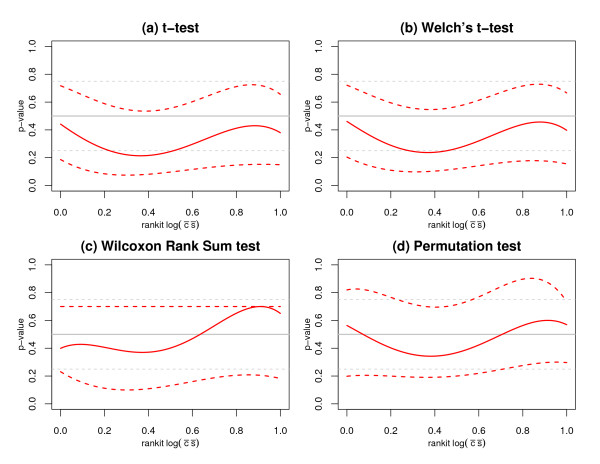
Estimates of the null p-value quartiles vary as a function of signal intensity for four common two sample test procedures applied to the re-loessed dataset 10a. The x-axes correspond to the rankit (i.e., rank of valuetotal#of values+1
 MathType@MTEF@5@5@+=feaafiart1ev1aaatCvAUfKttLearuWrP9MDH5MBPbIqV92AaeXatLxBI9gBaebbnrfifHhDYfgasaacH8akY=wiFfYdH8Gipec8Eeeu0xXdbba9frFj0=OqFfea0dXdd9vqai=hGuQ8kuc9pgc9s8qqaq=dirpe0xb9q8qiLsFr0=vr0=vr0dc8meaabaqaciaacaGaaeqabaqabeGadaaakeaadaWcaaqaaiabbkhaYjabbggaHjabb6gaUjabbUgaRjabbccaGiabb+gaVjabbAgaMjabbccaGiabbAha2jabbggaHjabbYgaSjabbwha1jabbwgaLbqaaiabbsha0jabb+gaVjabbsha0jabbggaHjabbYgaSjabcocaJiabb+gaVjabbAgaMjabbccaGiabbAha2jabbggaHjabbYgaSjabbwha1jabbwgaLjabbohaZjabgUcaRiabigdaXaaaaaa@52A7@) of the log of the product of the expression means. The y-axes correspond the observed two-sided p-values. Solid and dashed grey lines indicate the theoretical medians and quartiles, respectively. The null p-values were modeled as a function of a 4th order polynomial for rankit intensity. Red lines correspond to the quantile regression fits for τ = 0.5 (solid) and τ = 0.25, 0.75 (dashed). (a) P-values for the two sample t-test conducted under the assumption of equal variances. (b) P-values for the two sample t-test conducted under the assumption of unequal variances (a.k.a. Welch's test). Relaxing the assumption of equal variances provides for only a slight improvement in the distribution of the null p-values (c) P-values for the Wilcoxon Rank Sum test. (d) P-values for the permutation test [19,20]. Permutation based approaches are not robust to the systematic errors manifest in the Stage II data matrix.